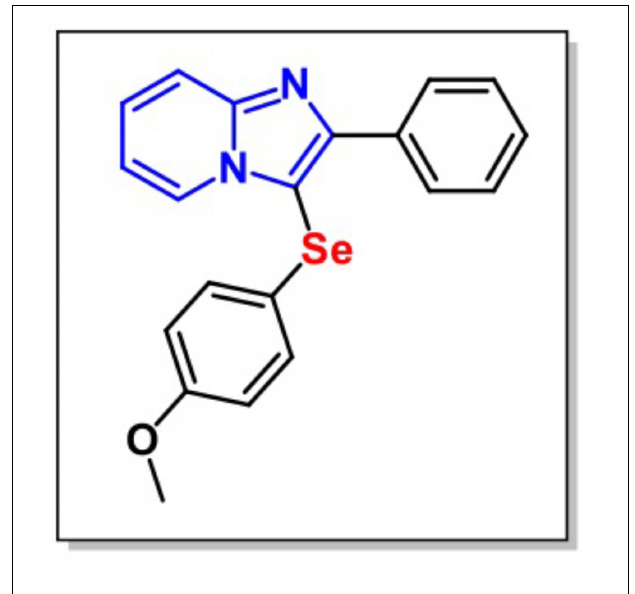
FIGURE 1 | Chemical structure of 3-((4-methoxyphenyl)selanyl)-2-phenylimidazo[1,2-a]pyridine (MPI).